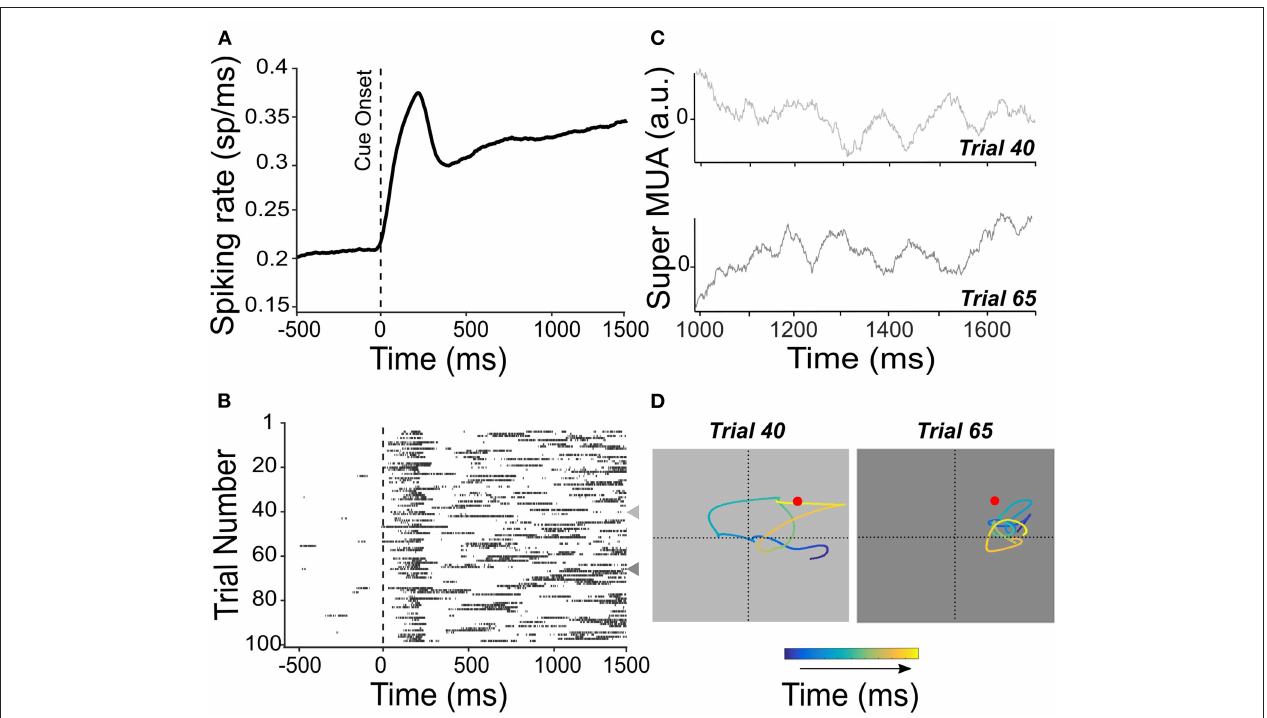
FIGURE 3 | Persistent activity is not persistent from one trial to the next. (A) Mean spiking rate activity across 100 trials is recorded from the FEF. Activity is locked to the cue presentation in the preferred location of the neuron. The spiking rate shows an average and sustained increase during the cue-to-target interval. (B) Raster plot showing the multiunit activity (MUA) locked to the cue onset for each of the 100 trials used for the average spiking rate shown in (A) . Represented individual trial spiking probability sets at a threshold of 65%. Trials 40 and 65 are indicated by a leftward-pointing gray triangle to show a different pattern of temporal activation. These trials are also considered in (C,D) . (C) The average MUA activity was obtained by averaging the activity recorded from all channels of the same electrode [super MUA, left FEF see Gaillard et al. (2020)] for trials 40 and 65 [indicated in (B) ]. (D) Attentional traces were obtained from high-resolution x -, y -coordinate decoding of the position of the attentional spotlight from the population neuronal activity, for trials 40 and 65, during the cue-to-target interval. Color code shows the time point along the cue-to-target interval of the decoded position of attention (blue to yellow, 700ms). Red dot indicates the position of the target stimulus in these trials.